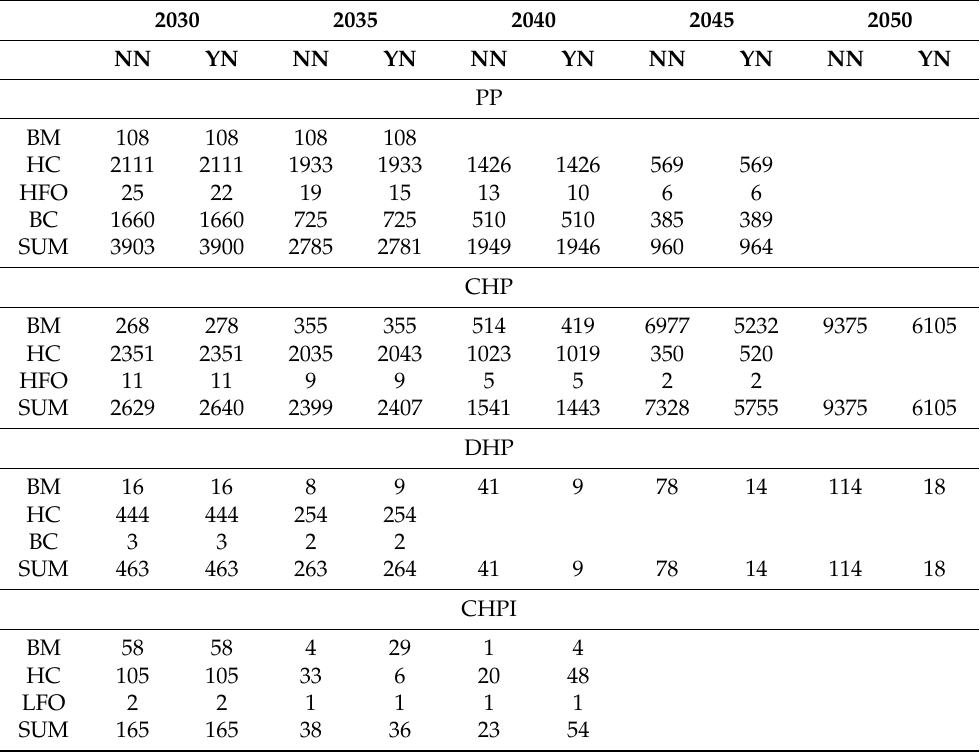
Table 7. Emissions of TSP between 2030 and 2050 from various fuels (BM: biomass, HC: hard coal, HFO: heavy fuel oil, BC: brown coal, LFO: light fuel oil) from public power plants (PP), public combined heat and power plants (CHP), district heating plants (DHP), and industrial combined heat and power plants (ICHP) for non-nuclear (NN) and nuclear (YN) scenarios (t). A blank field in the table means that a respective fuel is not used in a given model